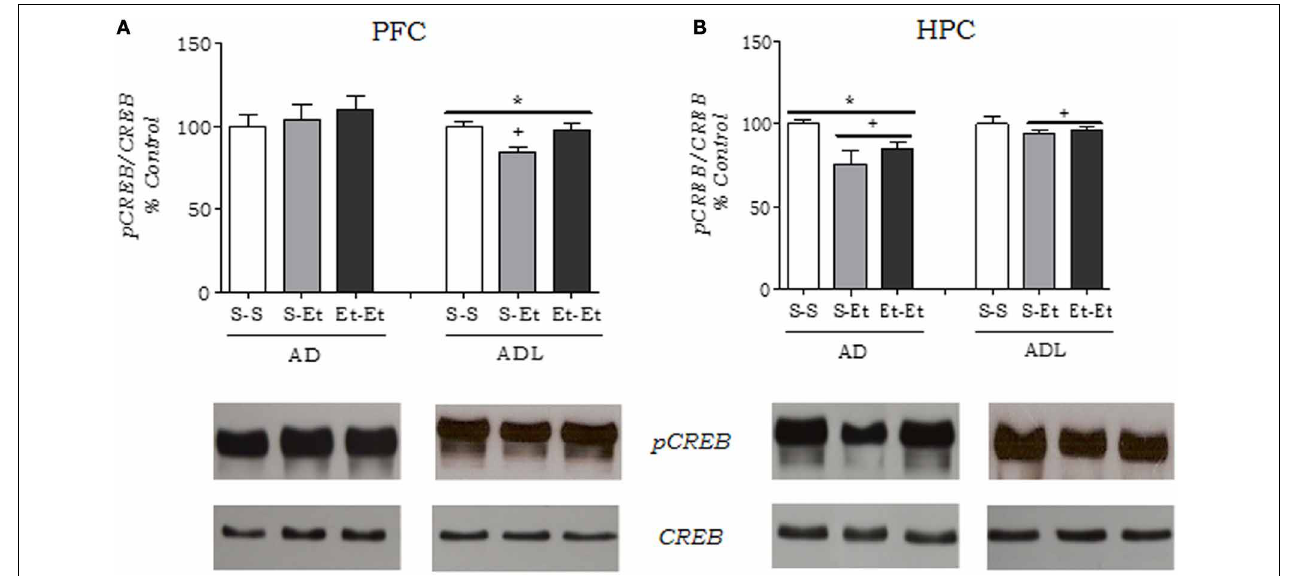
FIGURE 6 | Phosphorylated CREB levels assayed by Western blot in nuclear extracts of the (A) prefrontal cortex and (B) hippocampus in adult (AD) and adolescent (ADL) mice. Membranes were stripped and reprobed for total CREB, and the final values are expressed as the pCREB/CREB ratio calculated for each sample. The values are expressed as mean ± s.e.m. ( n = 6/group, randomly chosen from the groups used in the